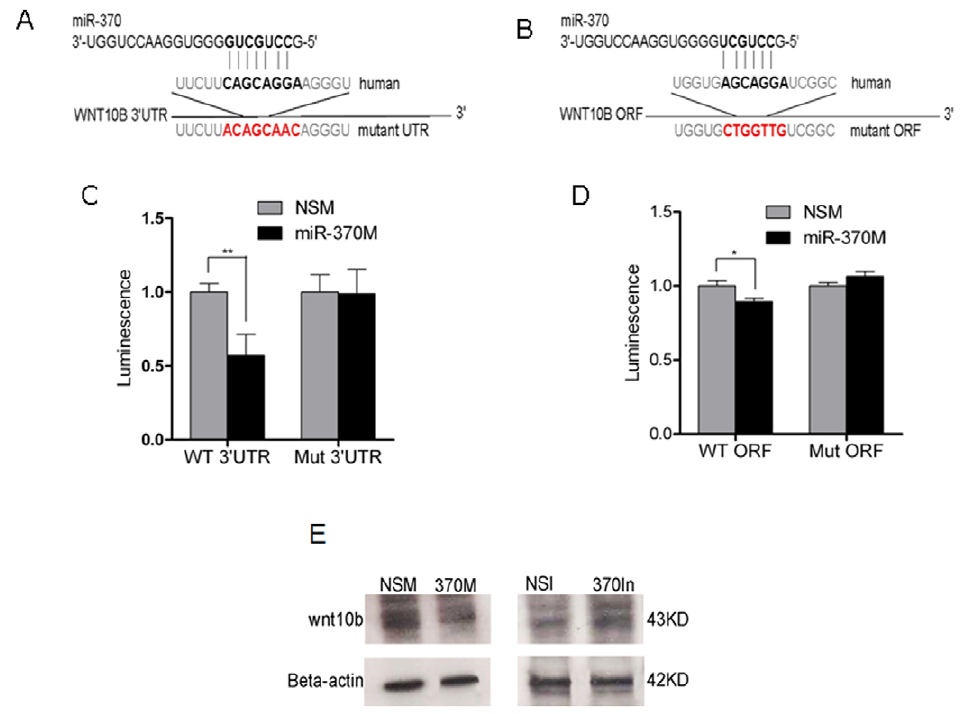
Figure 7. miR-370 modulates the expression of WNT10B. A and B. WNT10B is a putative target of miR-370. The seed of miR-370 displays complementarity to position 668–674 of WNT10B 3 9 UTR ( A ) as well as to position 458–464 of WNT10B ORF ( B ) in bold. Mutated nucleotides are shown in red. C and D. miR-370 binds directly to WNT10B. PGL4 luciferase reporter plasmids containing wild-type WNT10B 3 9 UTR (C) or open reading frame (ORF) (D) were cotransfected with miR-370 mimic (miR-370M) or non-specific mimic (NSM), respectively. The PGL4 plasmids containing mutant target site of the WNT10B 3 9 UTR or ORF were also cotransfected with miR-370M or NSM. The firefly luciferase activity was normalized to the Renilla luciferase activity for each sample. Data represents the mean value of three independent experiments. Mean 6 SD. *P , 0.05, **P , 0.01. E. WNT10B protein changes upon miR-370 manipulation. Equal protein loading was performed, as shown by b -actin. NSM – non- specifici mimic; miR-370M – miR-370 mimic; NSI – non specific inhibitor; miR-370In – miR-370